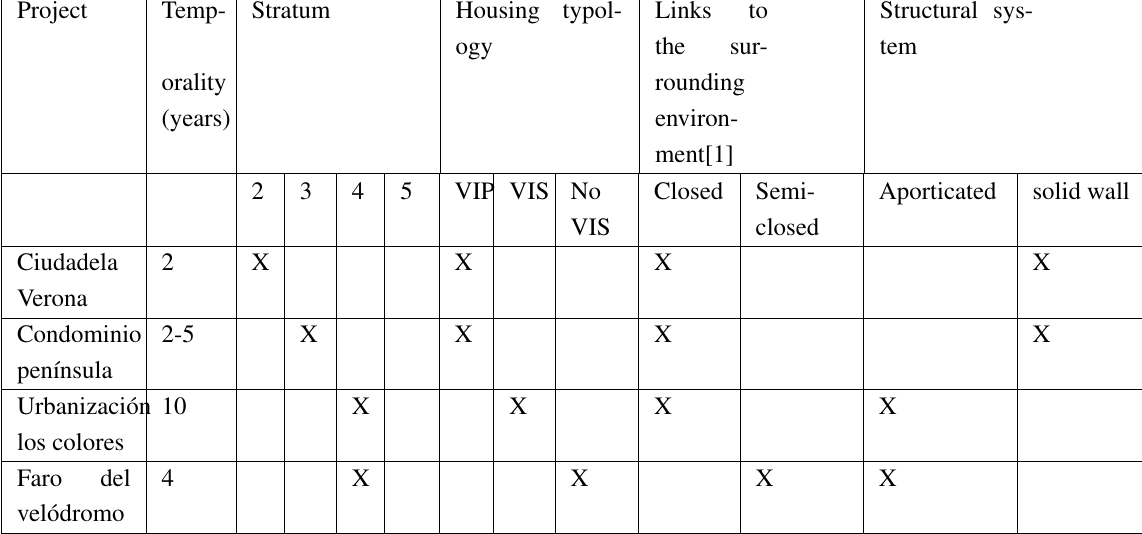
Table 1. Selected projects for the application of the HEPO